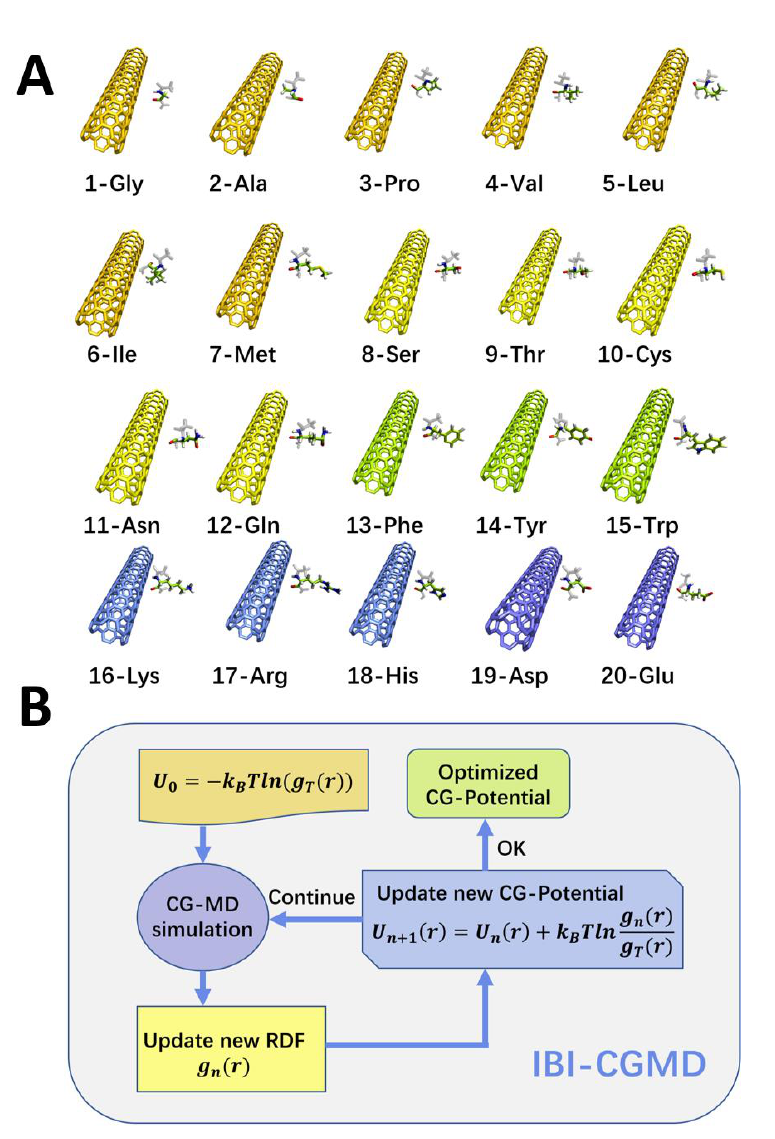
Figure 1. ( A ) Schematic diagram of the 20 amino acids – CNT55L3 simulation system. Amino acids are grouped as: (1) non-polar amino acid group (orange); (2) polar uncharged amino acid group (yellow); (3) aromatic amino acid group (green); (4) positively charged amino acid group (blue); and (5) negatively charged amino acid group (blue – purple part). ( B ) Simple schematic diagram of IBI process, IBI reverse Boltzmann iteration process to extract coarse-grained force field from all-atom trajectories, and 𝑈 0 is obtained from the AAMD.